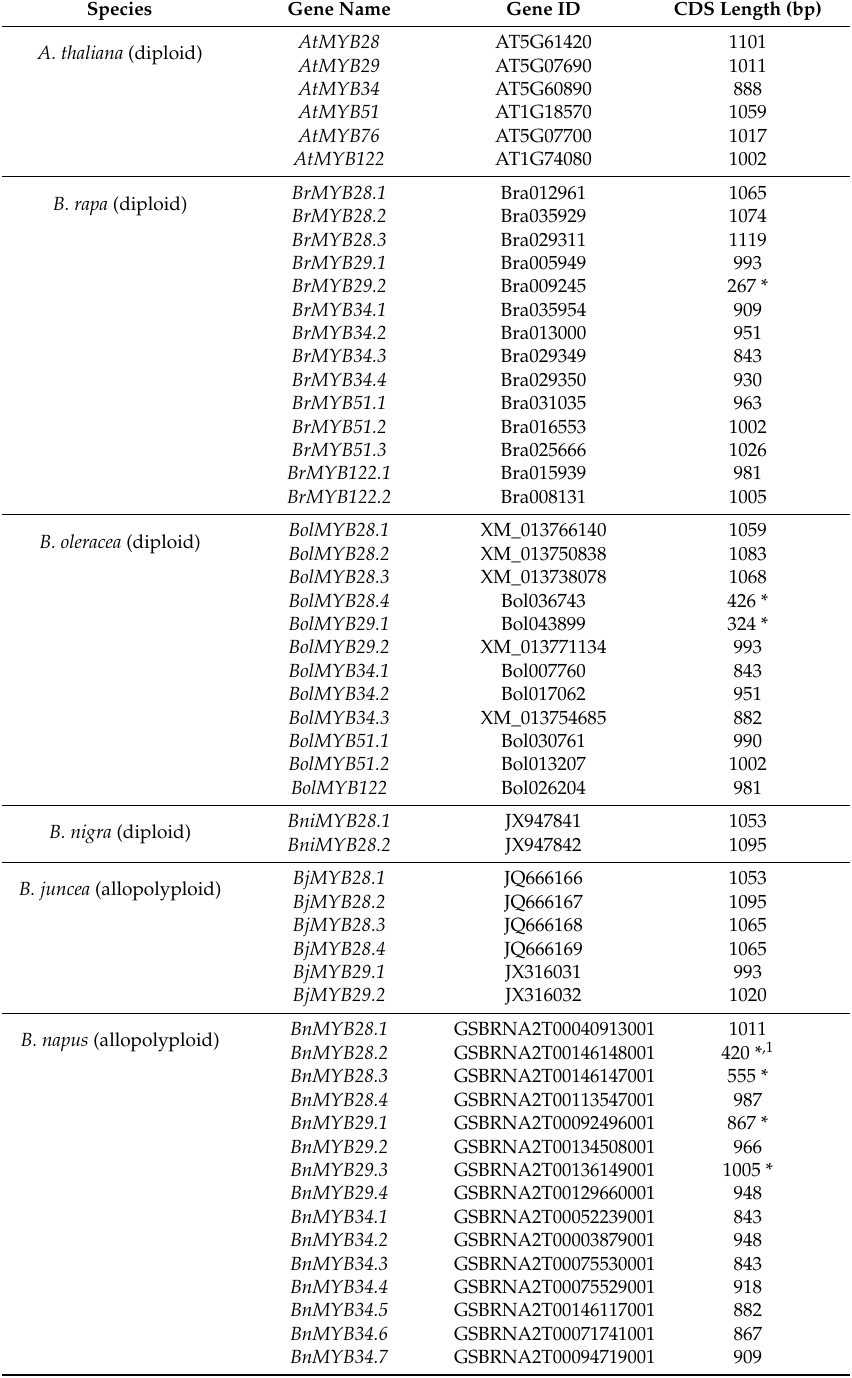
Table 1. DNA sequence summary of the MYB transcription factors related to glucosinolate biosynthesis in